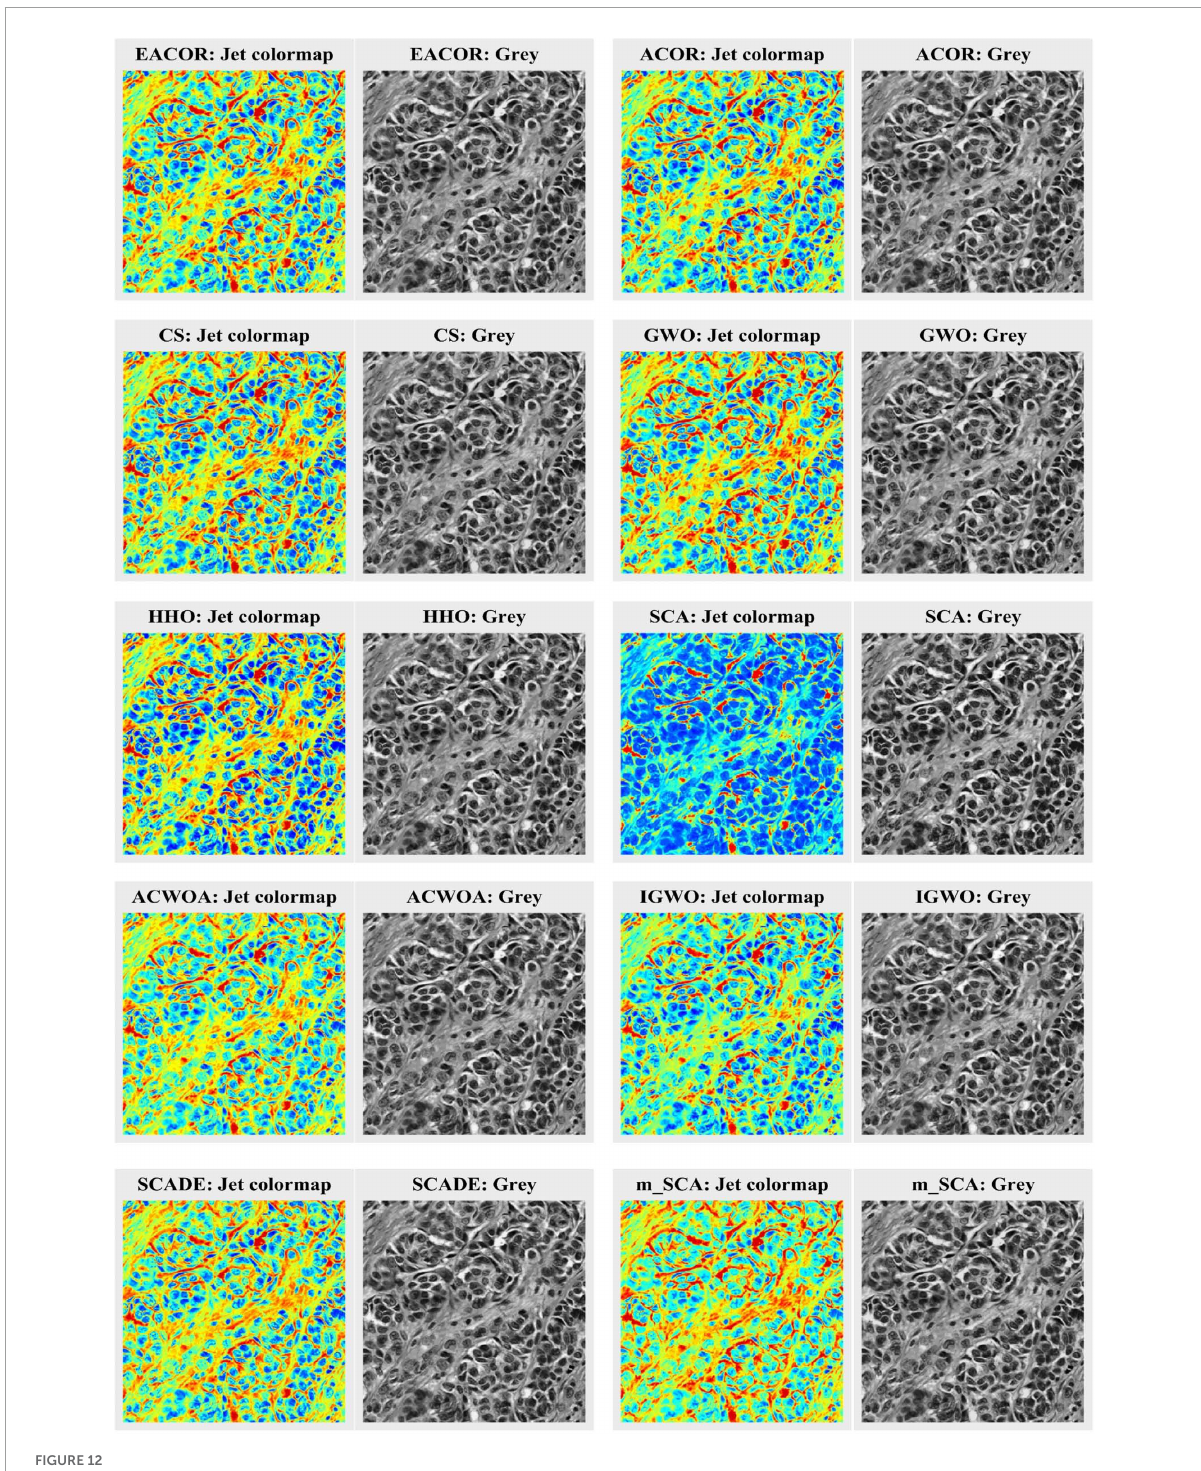
FIGURE12 Segmentation results of all algorithms.